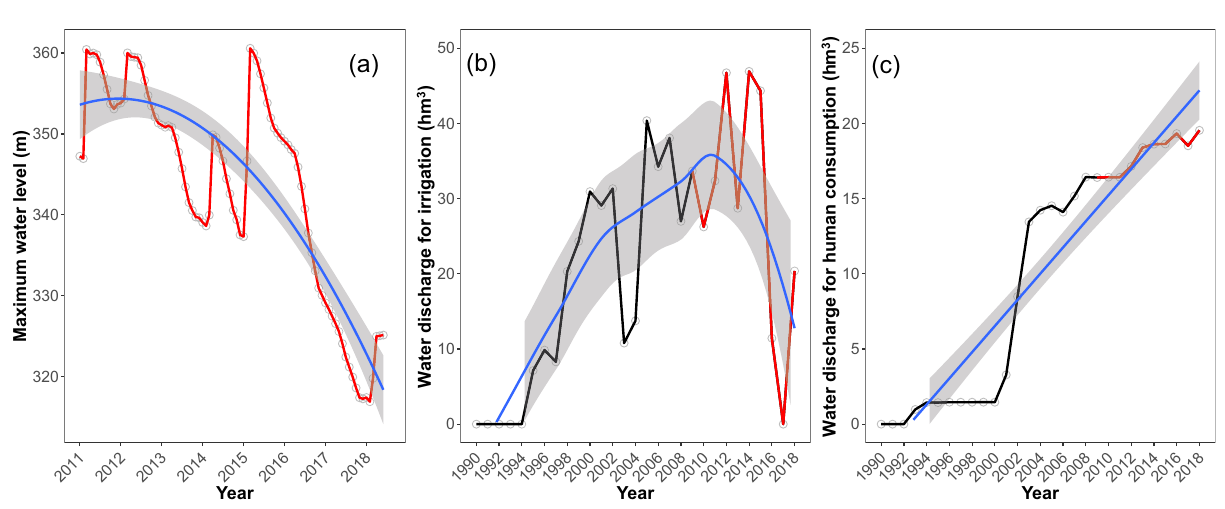
Figure 2. Variability in climatic conditions during 1980–2018 in the Seybouse watershed, northeastern Algeria. ( a ) Temporal pattern of the annual average (solid line), minimum (lower dashed line), and maximum (upper dashed line) temperature. The last ten years are highlighted in red (2009–2018). The blue line is the linear regression and the grey ribbon is the standard error. ( b ) Temporal pattern of the annual precipitation. The last ten years are highlighted in red (2009–2018). The blue line is a loess regression (grey ribbon is the standard error), indicating a decline in the last years. ( c ) Monthly values of Standardised Precipitation Evapotranspiration Index (SPEI) for the study region. Positive values (wet period) are in blue and negative values (dry periods) are in red. The dashed horizontal line is set to − 1.5, indicating severe drought. The dashed vertical line indicates the start of the last decade (2009). The black line is a loess regression, indicating a decline in SPEI during the last decade (a drier period).